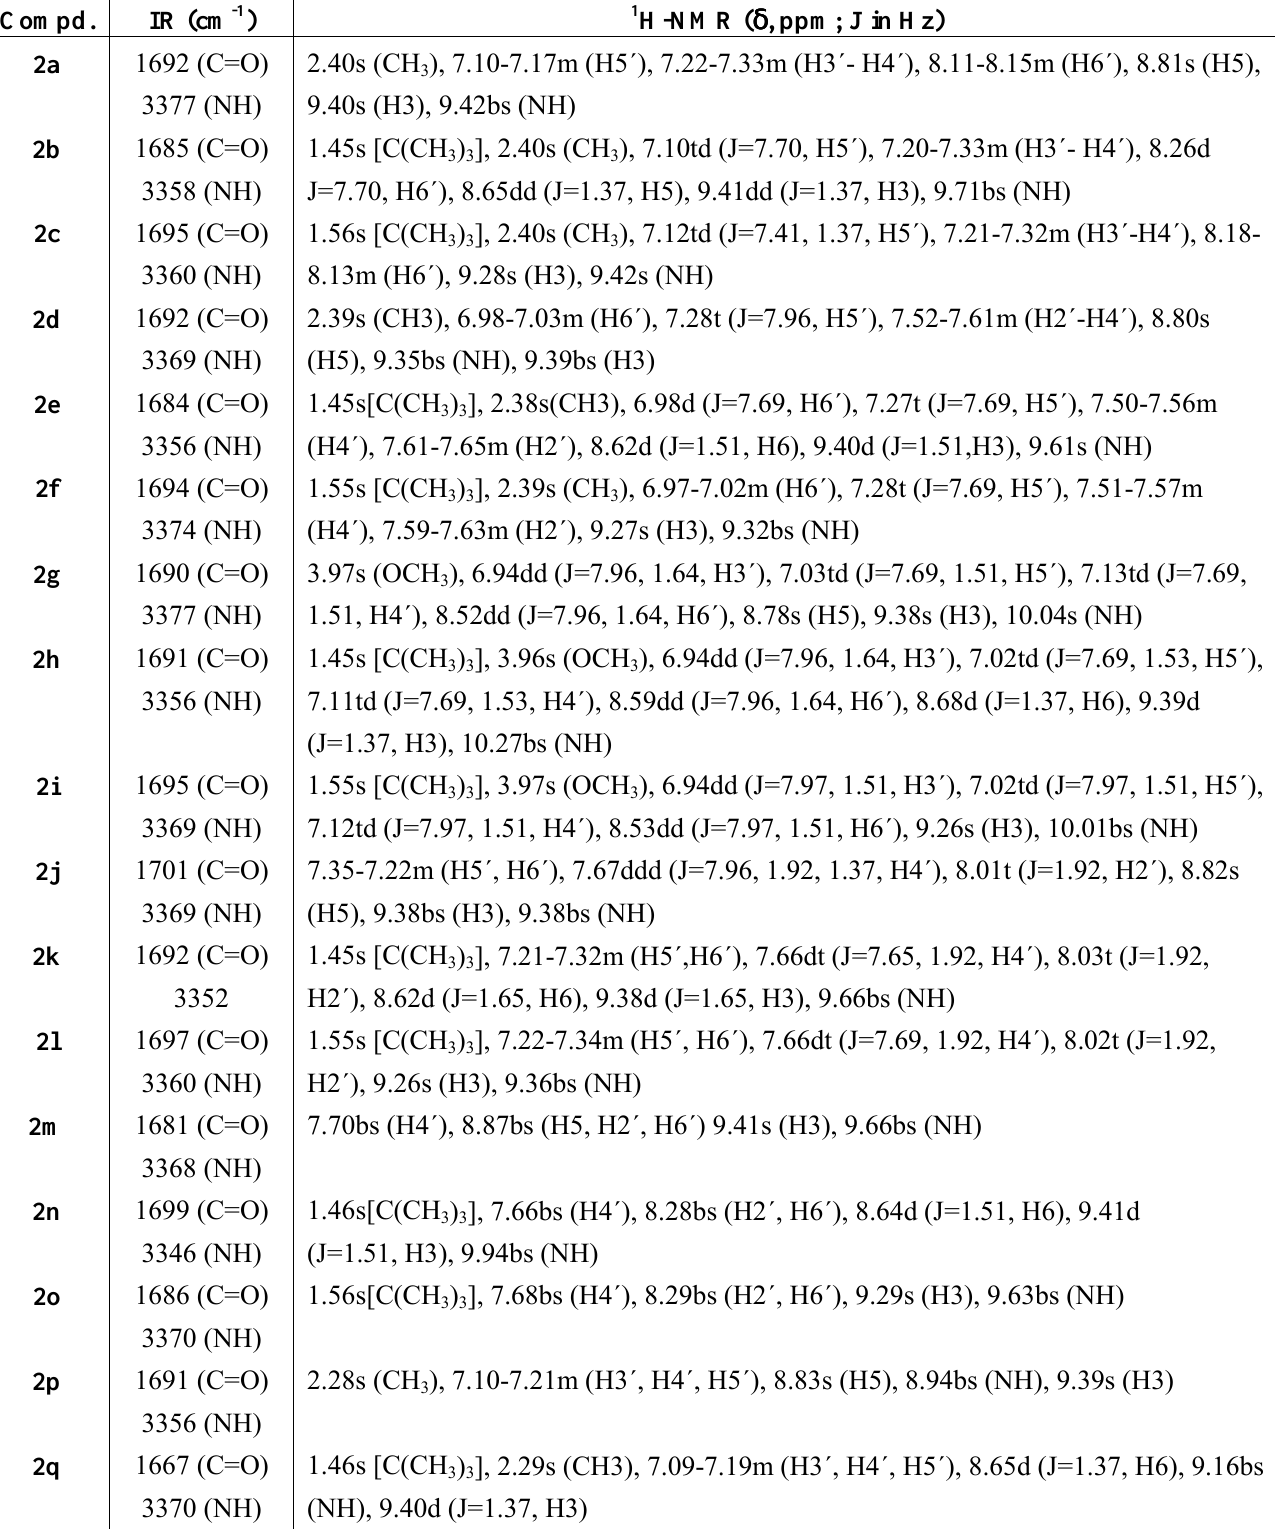
Table 4. IR and 1 H-NMR spectral data of the amides 2a-r